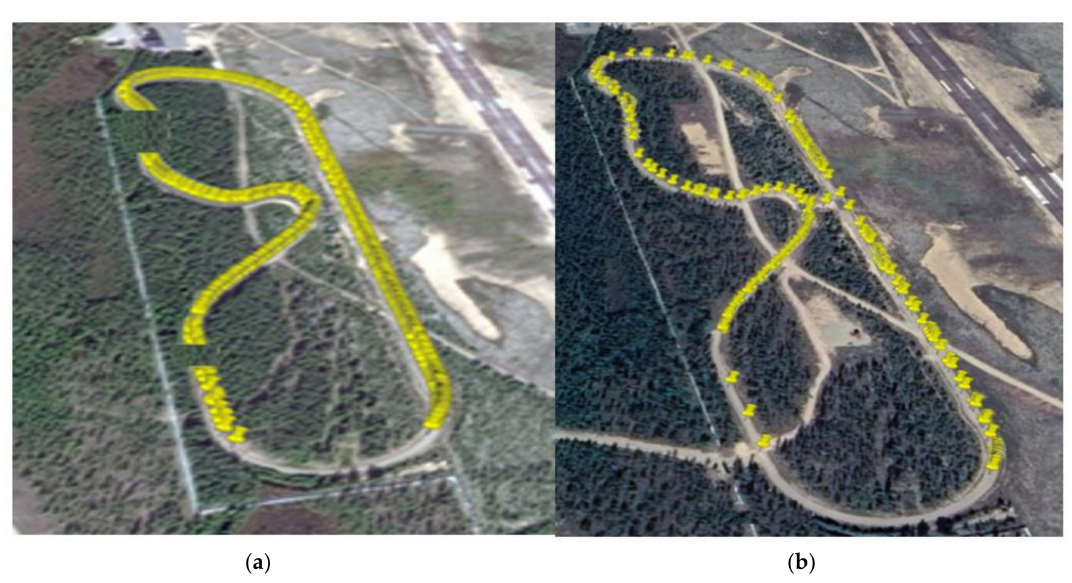
Figure 9. ( a ) Packet capture using the 5GTN. ( b ) Packet capture using the LTE